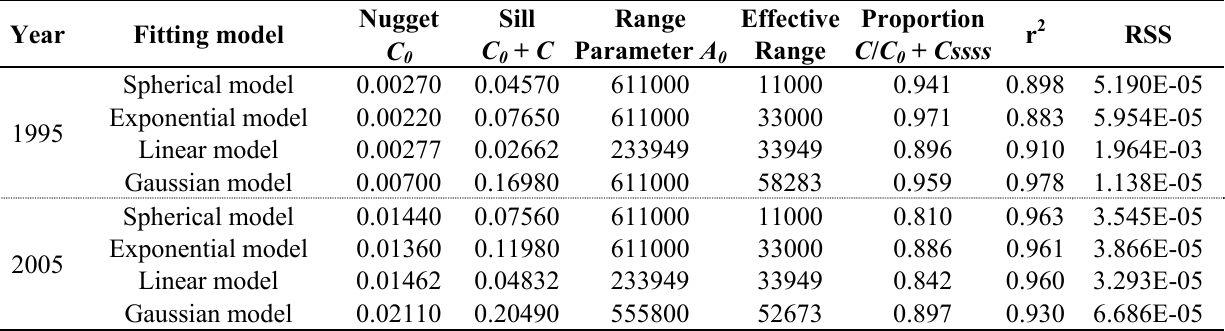
Table 4. Model parameter of isotropic variogram for land use eco-risk index in 1995 and